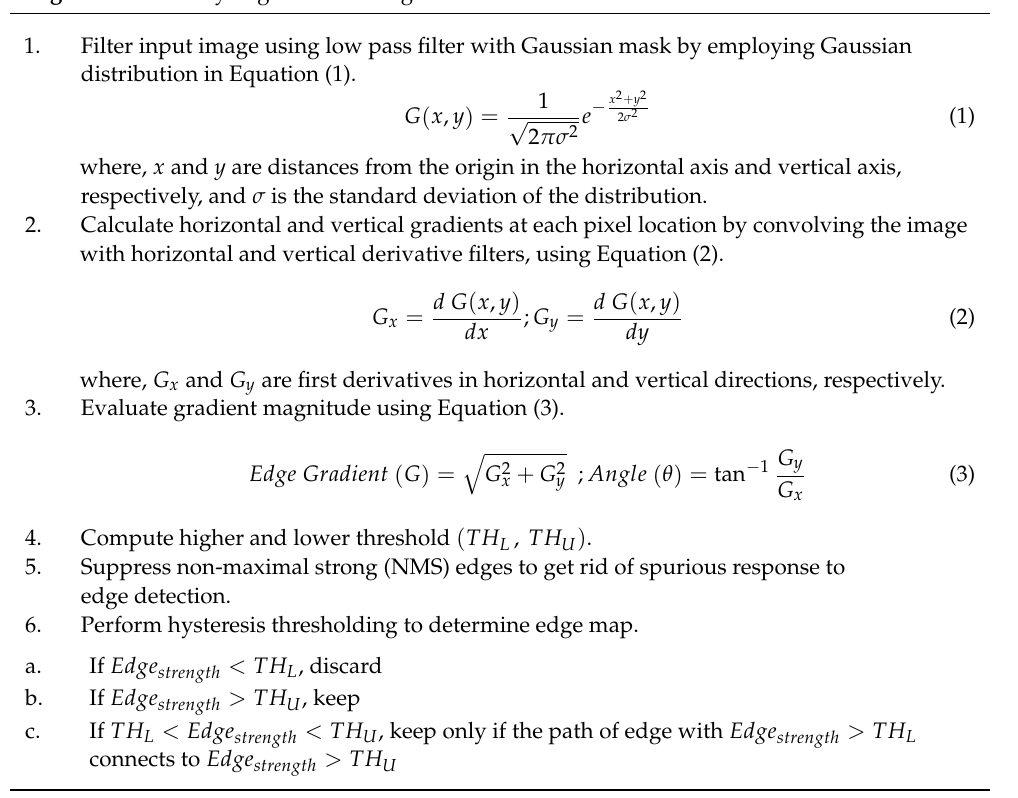
Algorithm 1. Canny edge detection algorithm